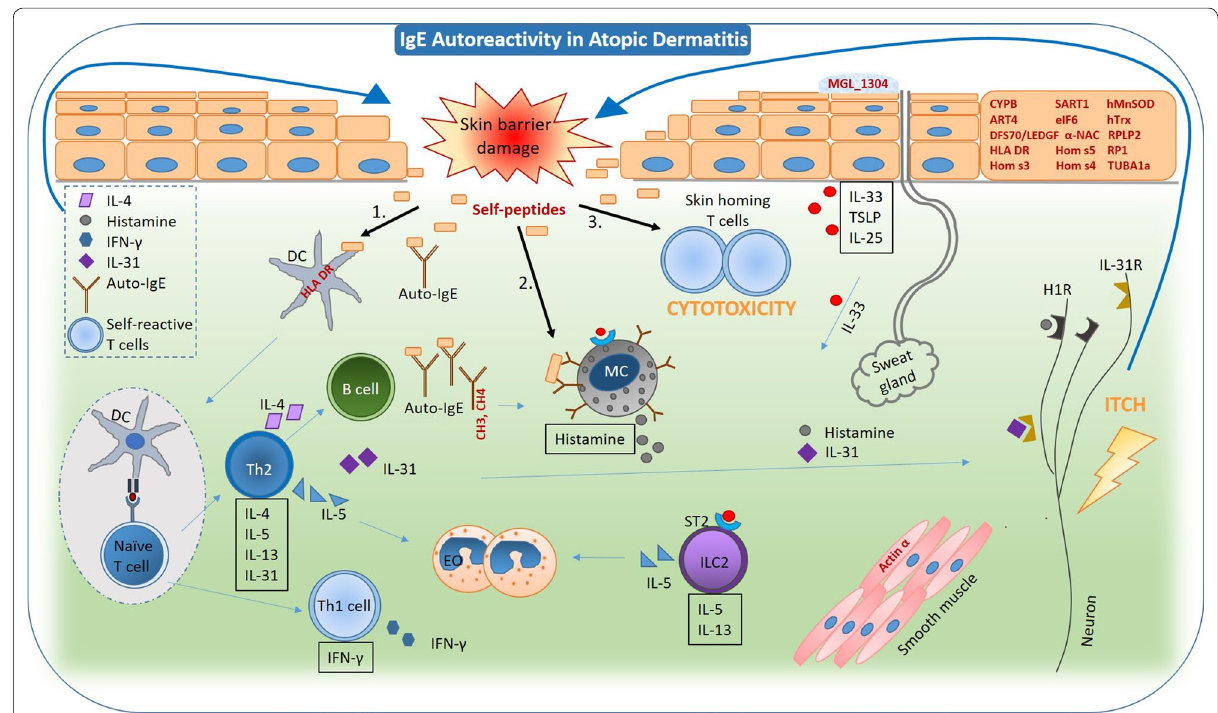
Fig. 3 Hypothetic cellular pathways and targets of autoreactivity in atopic dermatitis. Skin damage can lead to release of self‑peptides resulting in allergic sensitization to autoantigens via antigen presentation by dendritic cells (DC) to naïve T cells and class switch of B cells. Mast cells sensitized with IgE autoantibodies can directly interfere with the self‑peptides that are released following skin damage resulting in histamine release. T cells with low binding affinity to self‑peptides may escape selection and depletion in the thymus. Possibly, this population of cells may also be attracted to the skin where they are exposed to the self‑peptides of the damaged skin. Cytokines (IL‑4 and IFN‑γ) produced by T‑cells, and histamine by MC can directly exacerbate the skin lesion. Additionally, neurons in the skin can bind histamine and IL‑31 specifically to the histamine 1 receptor (H1R) and IL‑31 receptor (IL‑31R) which results in itch and may lead to the chronicity of the impaired barrier function. Th2 T helper lymphocyte, EO eosinophils, ILC2 innate lymphoid cell, IgE immunoglobulin E, IL interleukin, IFN-γ Interferon gamma, TSLP thymic stromal